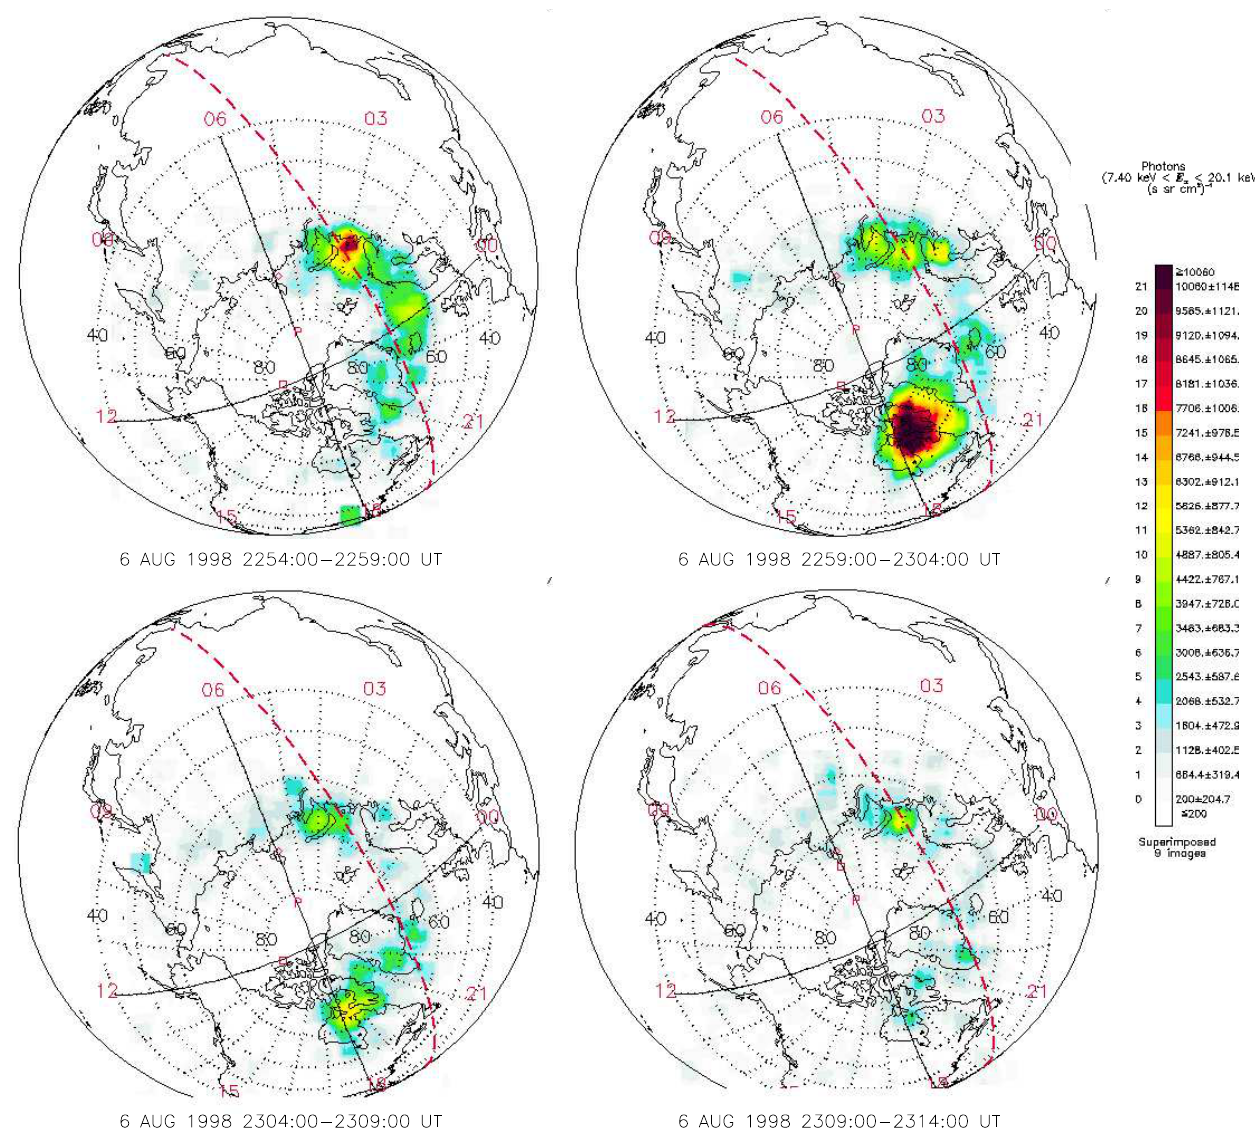
Fig. 4. Five minute integrations of X-rays with energies in the interval 7.40–20.1 keV from PIXIE on 6 August 1998, covering 22:54– 23:14 UT. The colour scale gives the X-ray intensity in units of photons/s/sr/cm 2 in the energy interval. The grid shows the CGM latitude and MLT. The terminator is indicated with a dashed